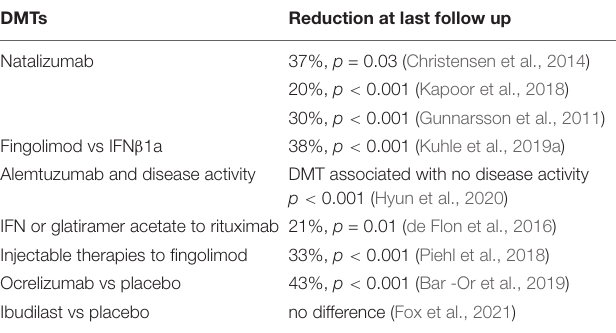
TABLE 1 | Reported reduction in NfL levels after treatment with DMTs.